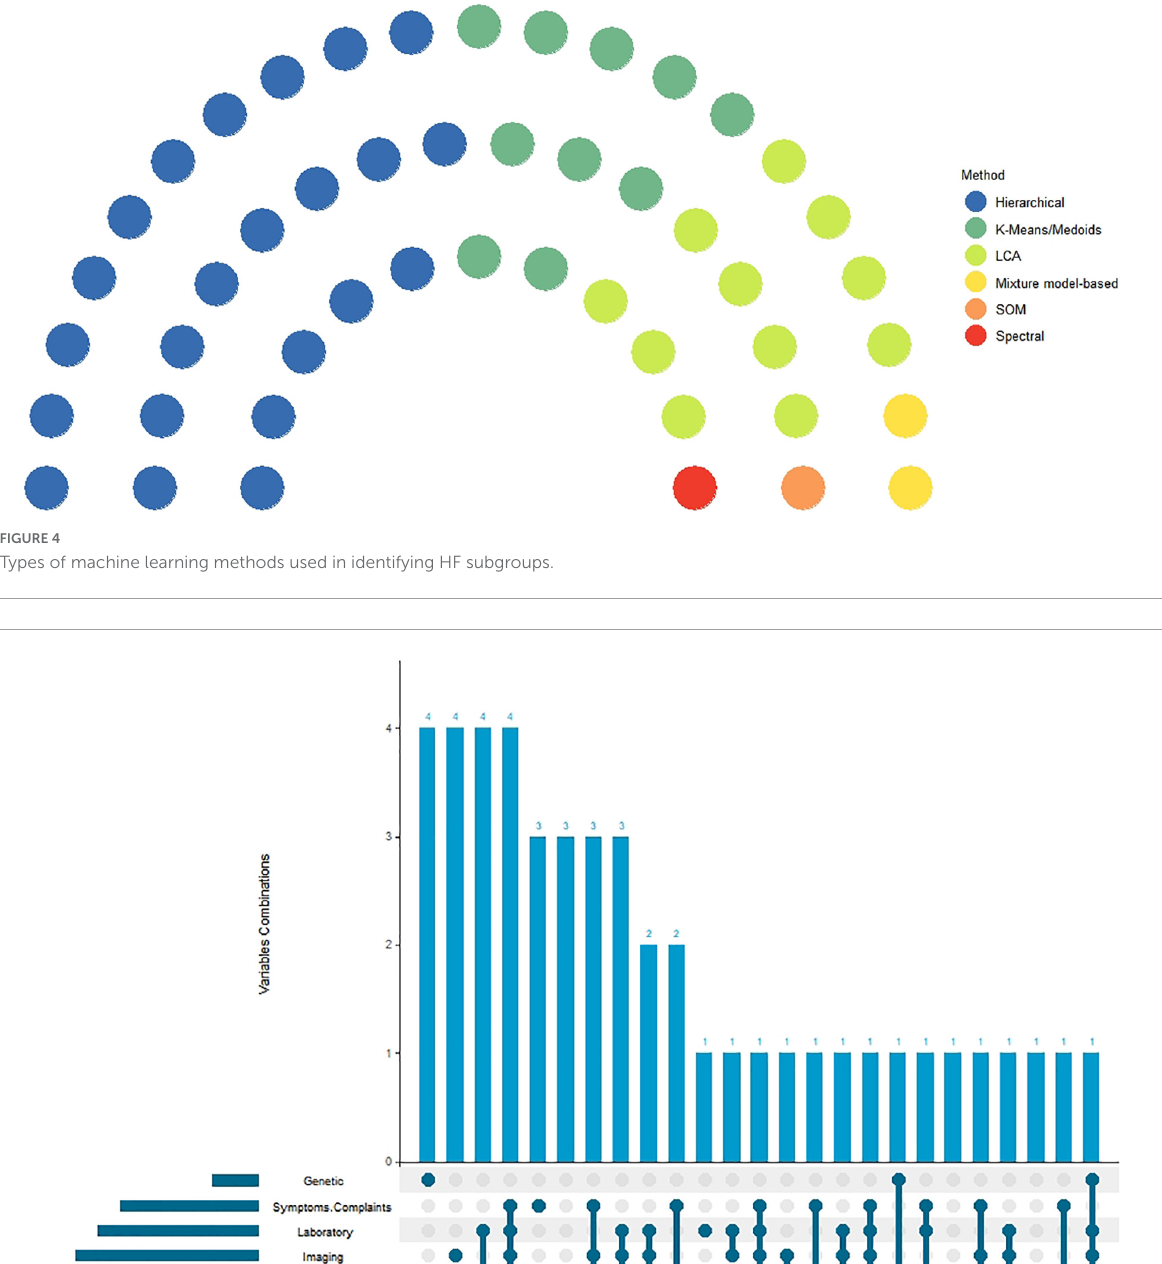
used data sets of more than 1,000 patients. At the same time, the number of clustering variables is relatively big, sometime even higher than the sample size, which may lead to overfitting